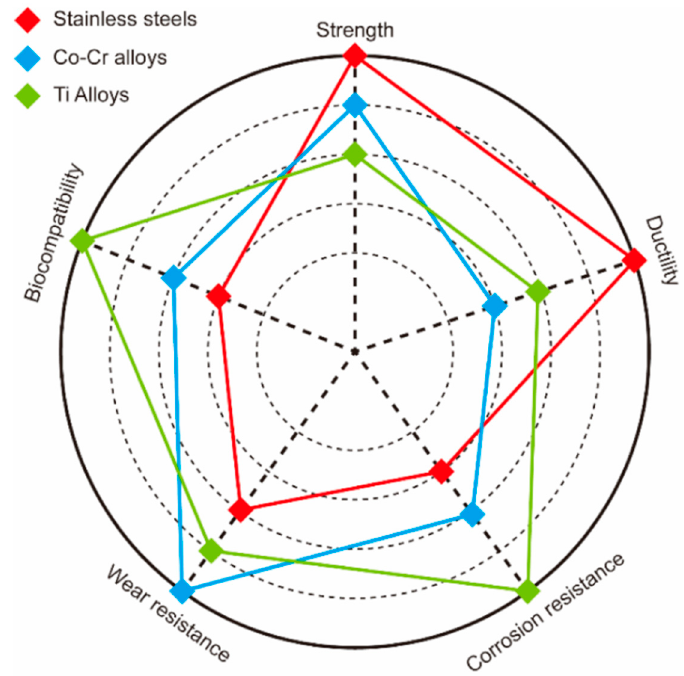
Figure 2. Evaluation of ductility, strength, corrosion, wear resistance, and biocompatibility of stainless steel ( red ), Co–Cr ( blue ), and Ti ( green ) alloys. Reprinted with permission from [25]. Copyright 2022 MDPI. Distributed under Creative Commons Attribution-based license (CCBY